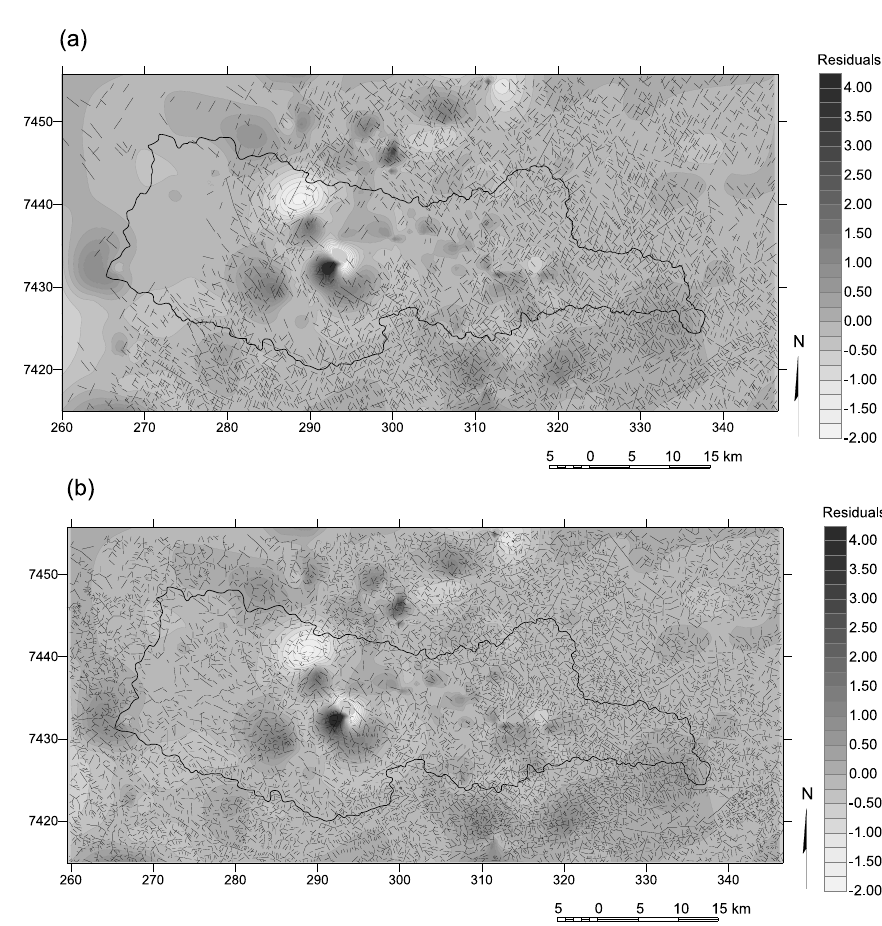
Fig. 4 – Residual maps of specific capacity of wells that exploit the Crystalline Aquifer System with the lineaments traced from (a) the radar images in 1:250.000 scale and (b) the aerial photography in 1:60.000 scale.